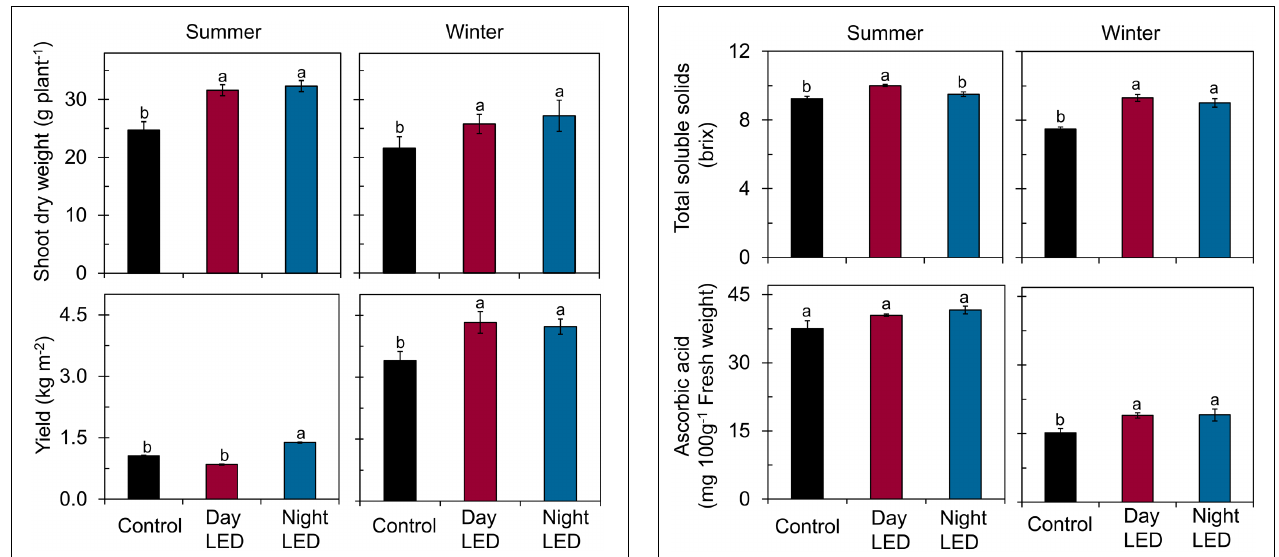
FIGURE 6 | Total soluble solids and ascorbic acid content of tomato fruits. Measurements were made from single-truss tomato fruits grown under daytime or nighttime LED inter-lighting or control. Data represent means ± SE ( n = 10). Different letters indicate statistically significant differences (Tukey’s HSD at P <